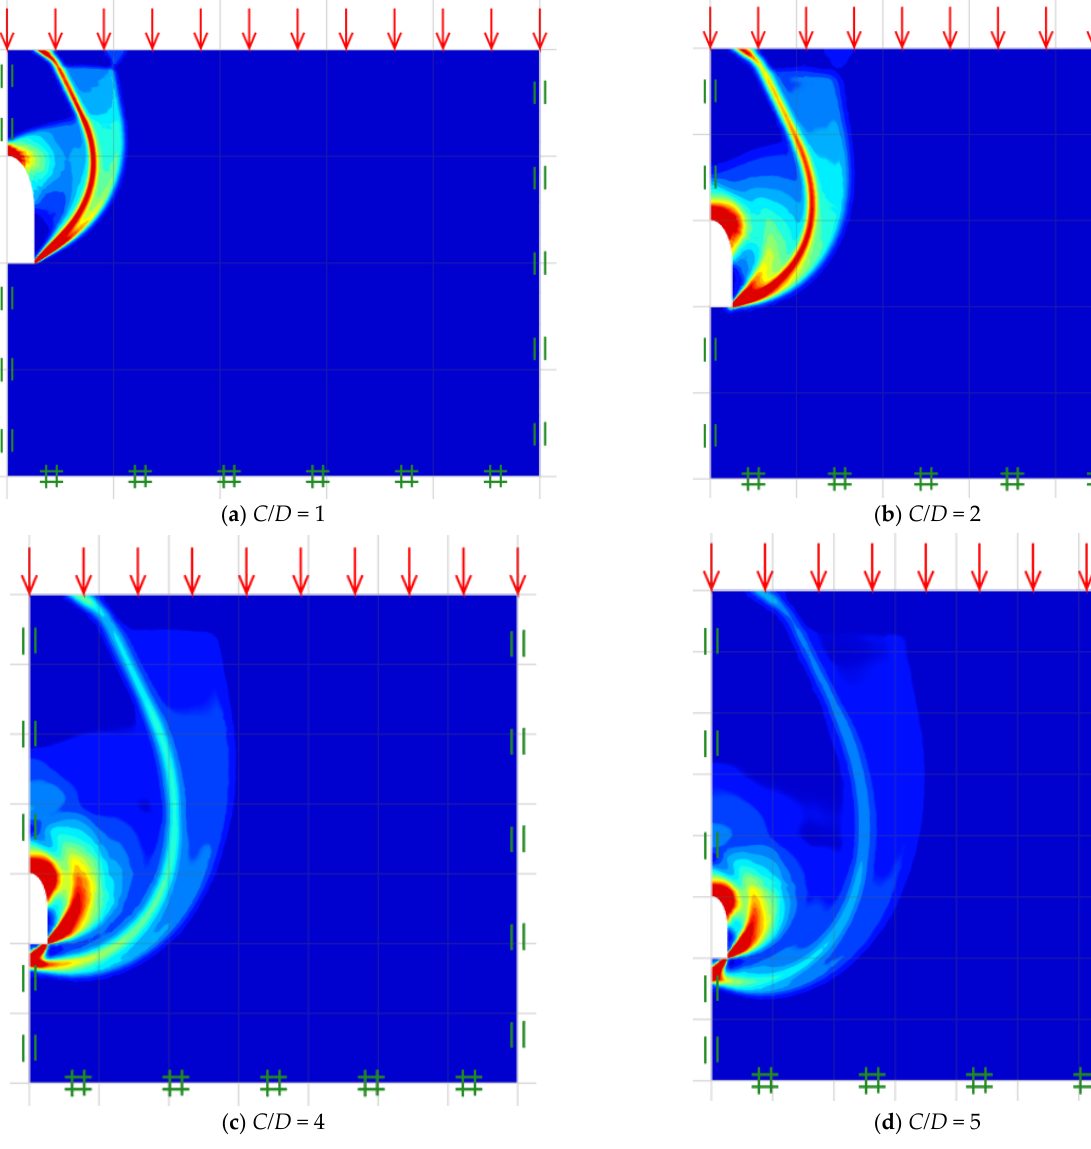
Figure 11. Shear dissipations for various C/D (B/D = 0.5 , γ D/c' = 0 and ϕ = 20°).